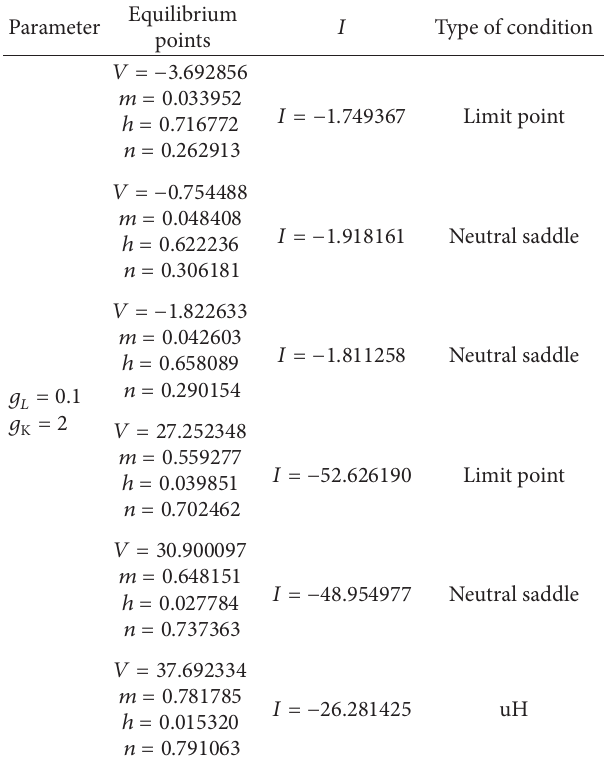
Figure 12: The limit cycle emerging from uH at 𝐼 = 7.131765 and sH at 𝐼 = 115.224276 . Table 2: Bifurcation analysis results derived by the Matcont soft- ware.